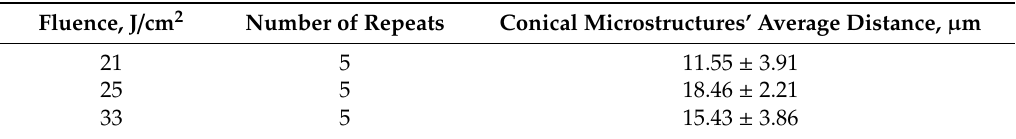
Figure 9. Image analysis for conical microstructures for 21 J/cm 2 with five scan repetitions: ( a ) SEM image with conical microstructures; ( b ) fourier transform graph with a peak corresponding to the average conical structure size marked in red.